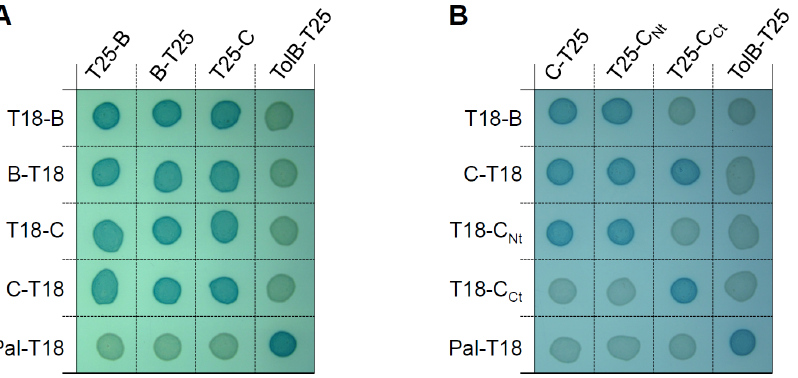
Figure 1. TssB1 interacts with the N-terminal domain of TssC1. BTH101 reporter cells carrying pairs of plasmids producing the indicated T6SS proteins or domains (B, TssB1; C, TssC1; C Nt , N-terminal domain of TssC1; C Ct , C-terminal domain of TssC1) fused to the T18 or T25 domain of the Bordetella adenylate cyclase were spotted on X-Gal indicator LB agar plates. Controls include T18 and T25 fusions to TolB and Pal, two proteins that interact but unrelated to the T6SS.